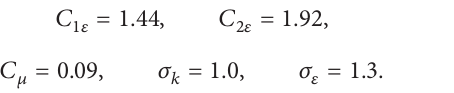
due to buoyancy, while 𝑌 𝑀 represents the contribution of the fluctuating dilatation in compressible turbulence to the overall dissipation rate. The model constants 𝐶 1𝜀 , 𝐶 2𝜀 , 𝐶 𝜇 , 𝜎 𝑘 , and 𝜎 𝜀 have been determined by Laundar and Saplding